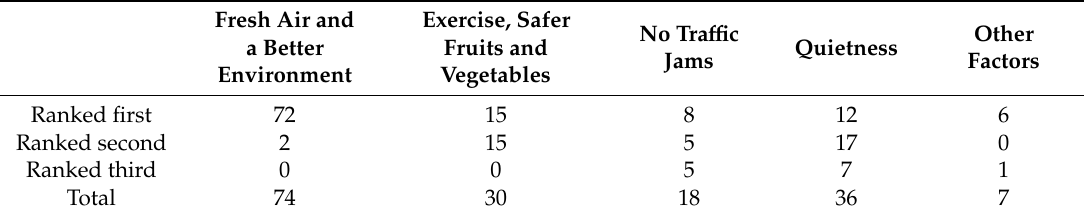
Table 4. The main reasons for urban residents to buy or rent farmhouses.